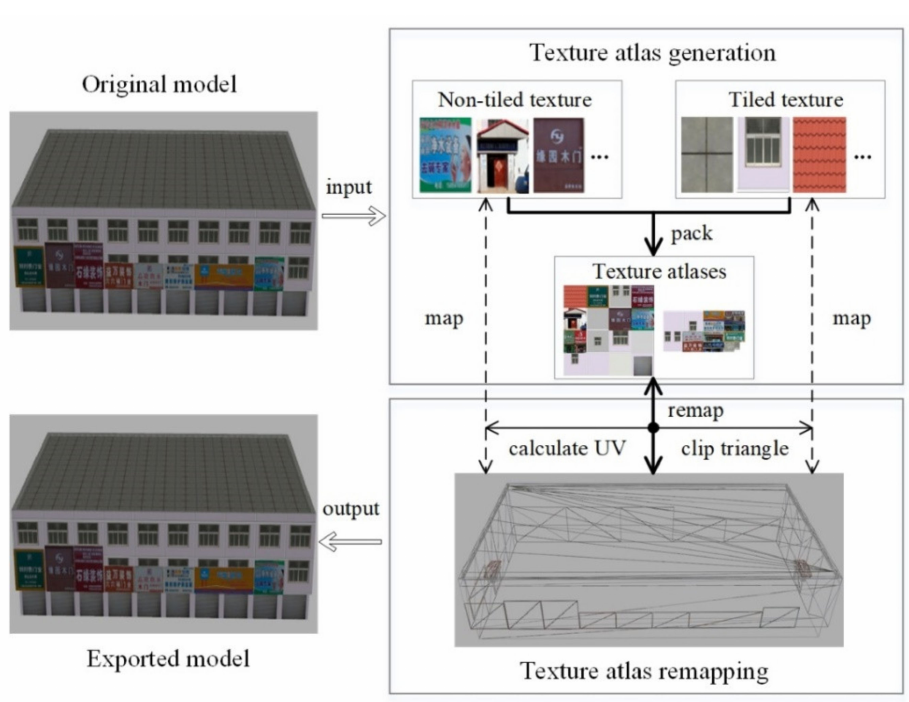
Figure 1. Texture atlas generation and remapping